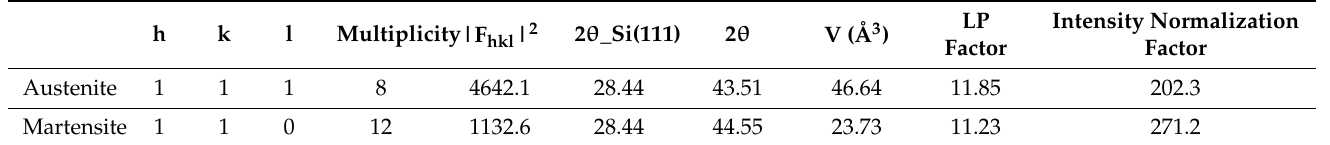
Table 2. Parameters used to calculate the intensity normalization factors for austenite {111} peak and martensite {110}. The meanings of the parameters are explained in the text associated with Equations (1) and